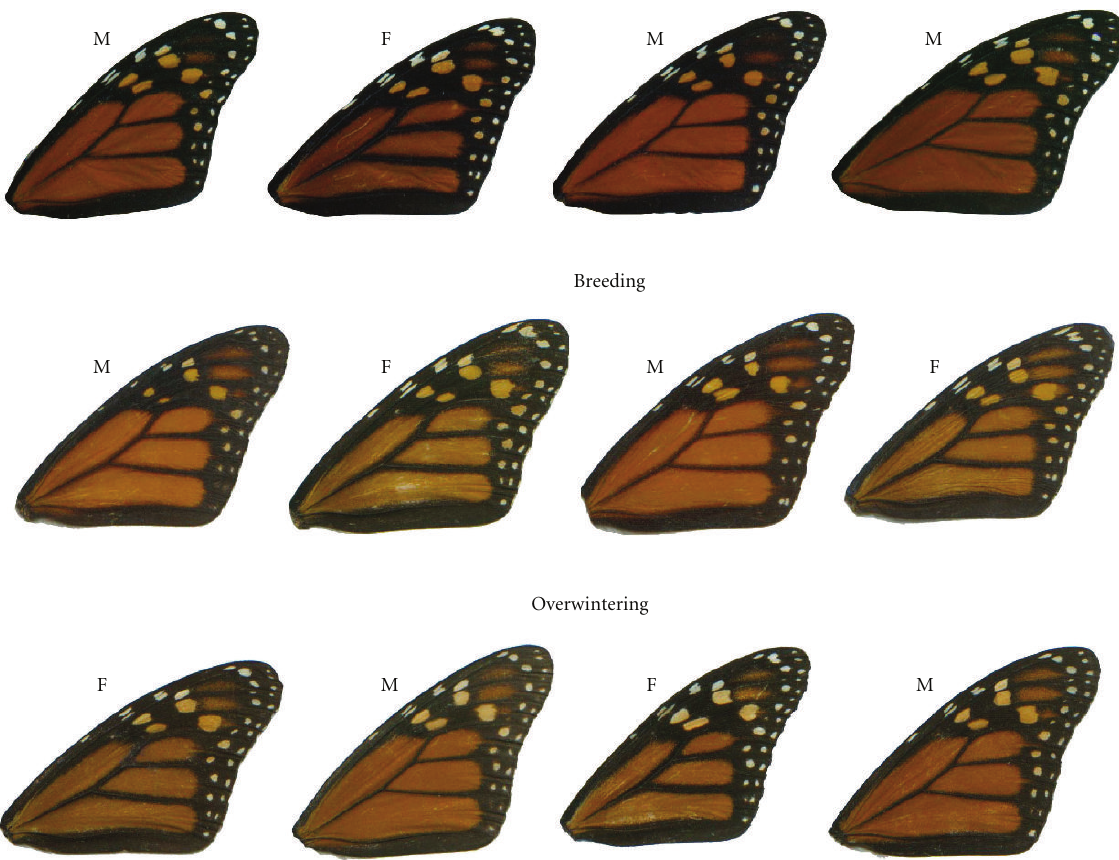
Figure 4: Forewings of selected migrant, breeding, and overwintering monarch butterflies. Note the di ff erence in orange color between migrants and all others. All wings were scanned with the same scanner using the same settings. Males (M) and females (F) are